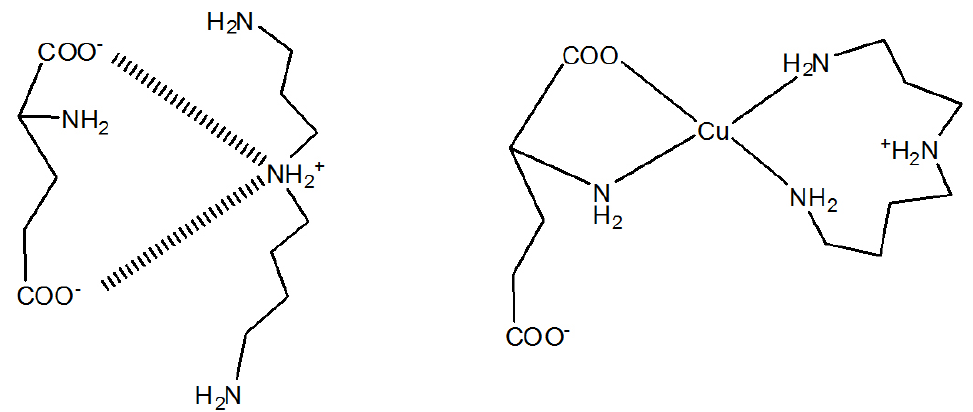
Scheme 3: Tentative mode of interaction in the (Glu)H(Spd) and Cu(Glu)H(Spd) complexes.